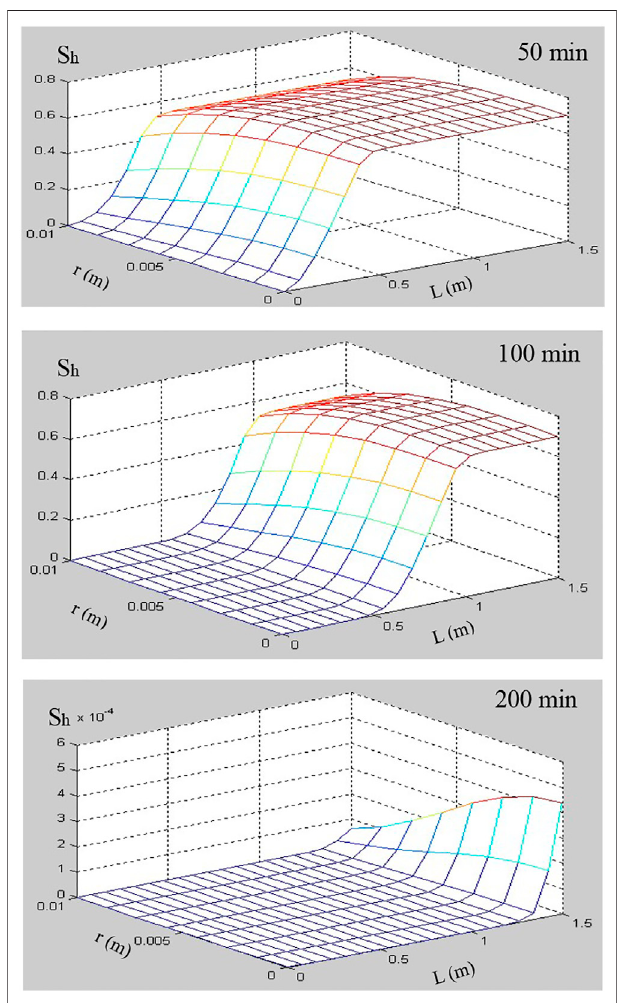
FIGURE 9 | Time evolution of hydrate saturation for the initial hydrate saturation of 70%.